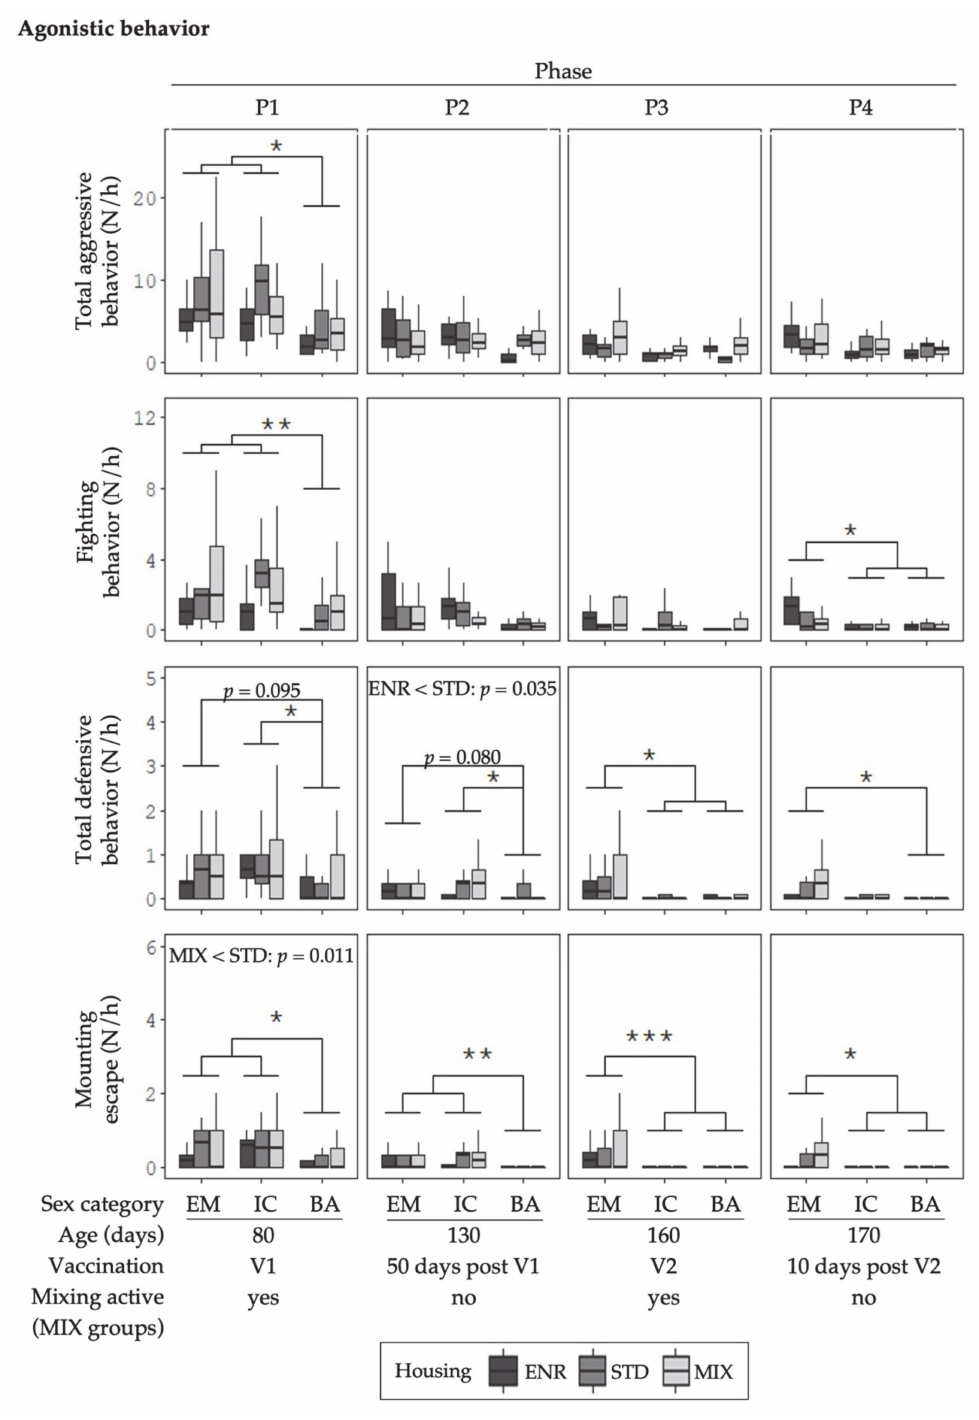
Figure 2. Mean number of occurrences (N) of agonistic behaviors per hour (h) for each animal are given as boxplots for the sex categories (EM = entire males, IC = immunocastrates, BA = barrows) in the different environments (ENR = enriched, STD = standard, MIX = mixing). Columns represent the data of animals in four behavior observation phases (P1–P4). V1 represents phases before, and V2 after the second immunization of IC. The MIX pens were mixed in P1 and P3. Note: no mixing was done in STD and ENR at any time. Significant differences between sex categories are indicated by asterisks (*** p < 0.001, ** p < 0.01, * p < 0.05). Housing differences are annotated with p -values in the graphs respectively. Boxplots show the minimum value with respect to the interquartile range, the 25th percentile, the median, the 75th percentile and the maximum value with respect to the interquartile